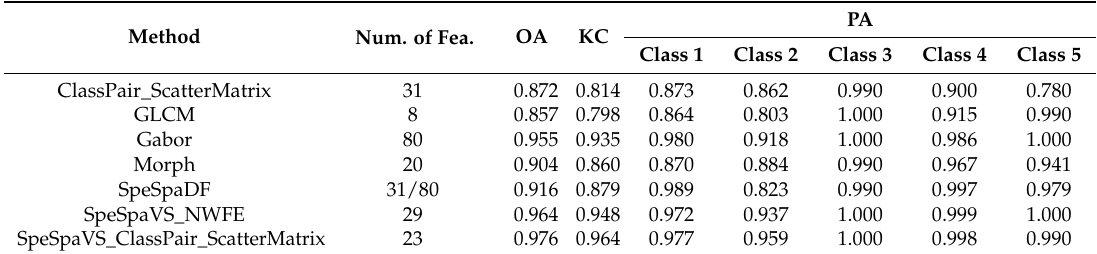
Table 3. Performance of the methods investigated in the paper on data set 1. GLCM: gray-level co-occurrence matrix; NWFE: nonparametric weighted feature extraction.